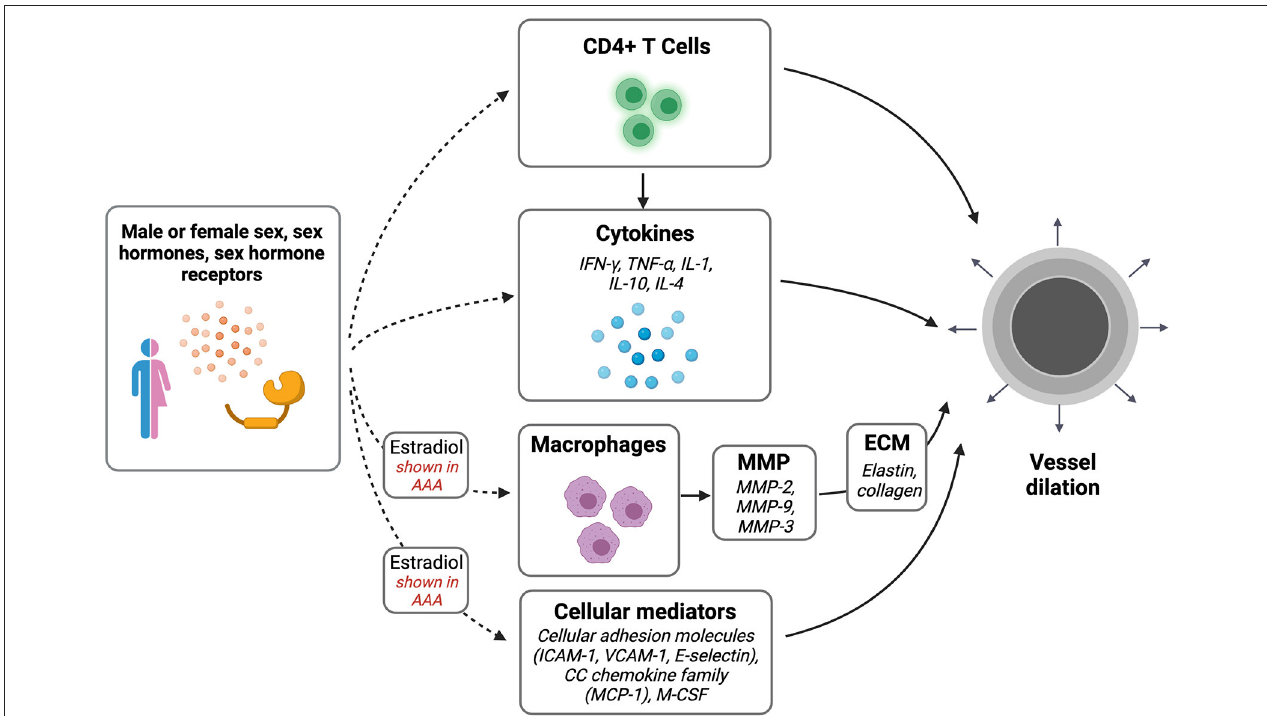
FIGURE 1 | Sex differences in vascular dilation. Potential pathways of interest in vessel wall dilation that may be affected by sex, sex hormones, and sex hormone receptors. Created with